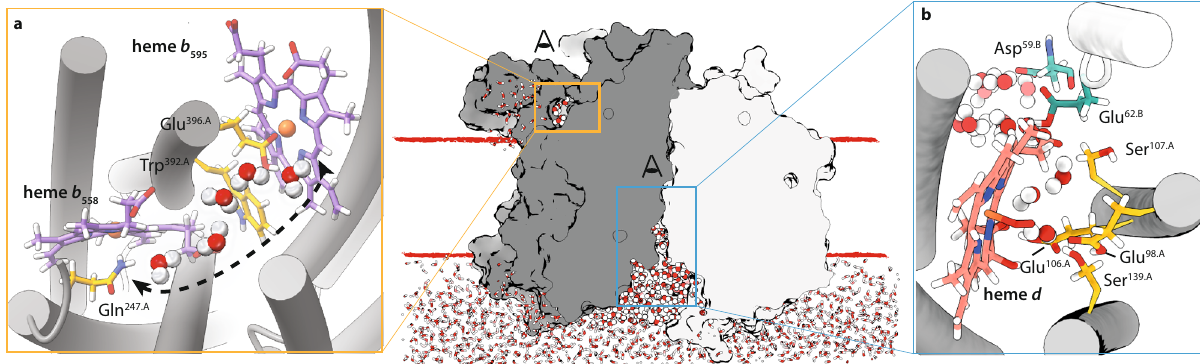
Fig. 2 Molecular dynamics simulation of interior hydration. Representative snapshots of solvent molecules consistently identi fi ed in MD simulation runs. a The left panel shows the newly identi fi ed water chain between the b-type hemes in top view orientation. b The right panel shows the path of water molecules entering at the CydAB interface and running towards the oxygen reduction site. Residues lining the putative proton channel are indicated. CydA, gray; CydB, light grey; b -type hemes purple; heme d , coral. Water molecules are shown as tri-sphere units (O: red; H: